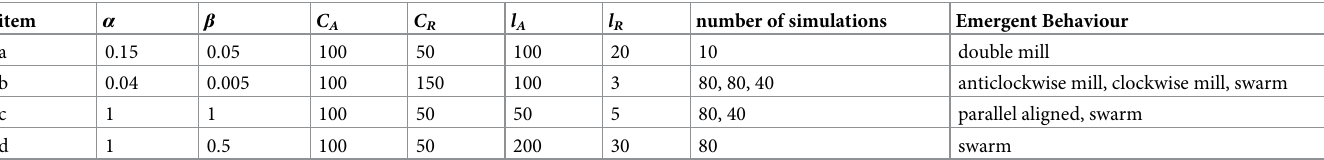
Table 3. Modelling parameters and emergent collective motion patterns for the ODE model with N = 10 individuals.